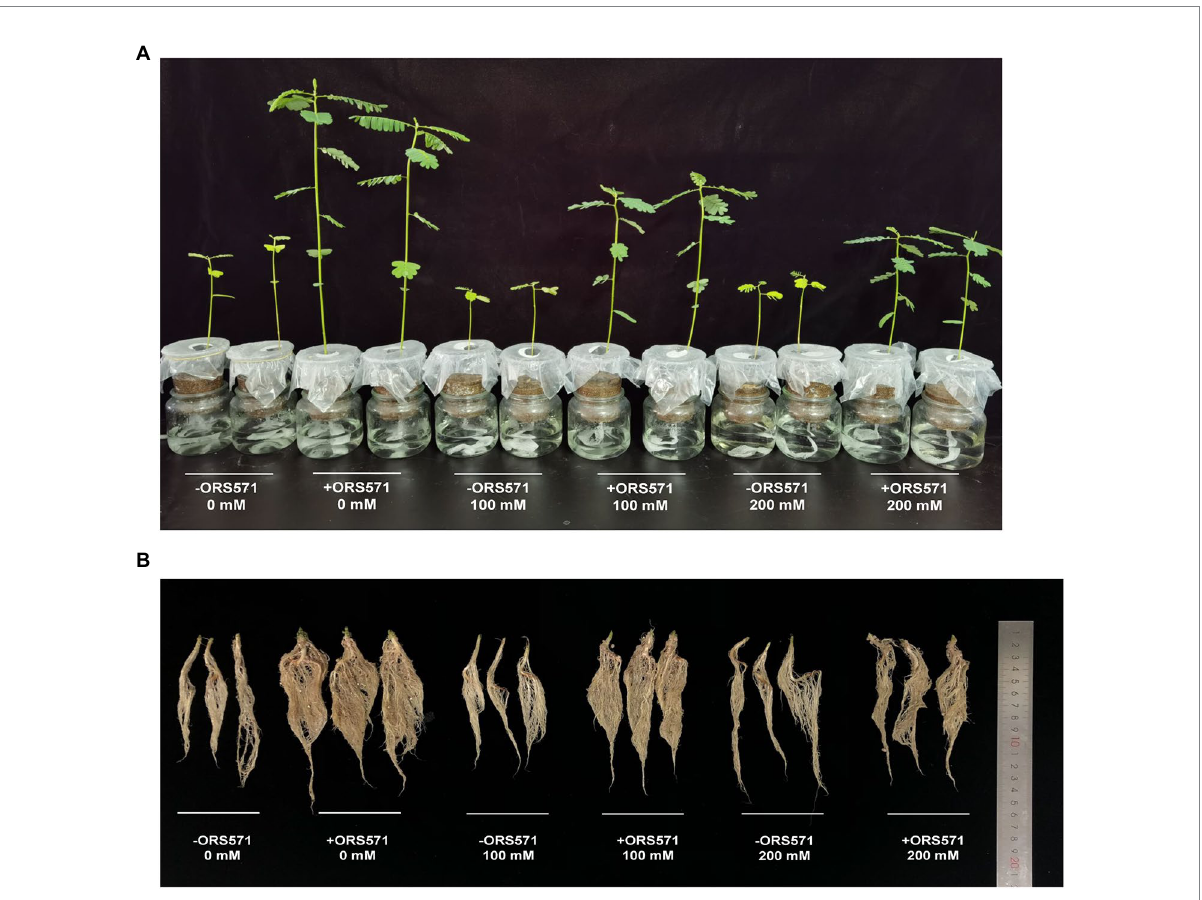
FIGURE 1 Representative images of Sesbania rostrata inoculated with ORS571 or uninoculated group as a control at different salt concentrations for 20 days. (A) Growth condition of the aboveground part. (B) Growth condition of the underground